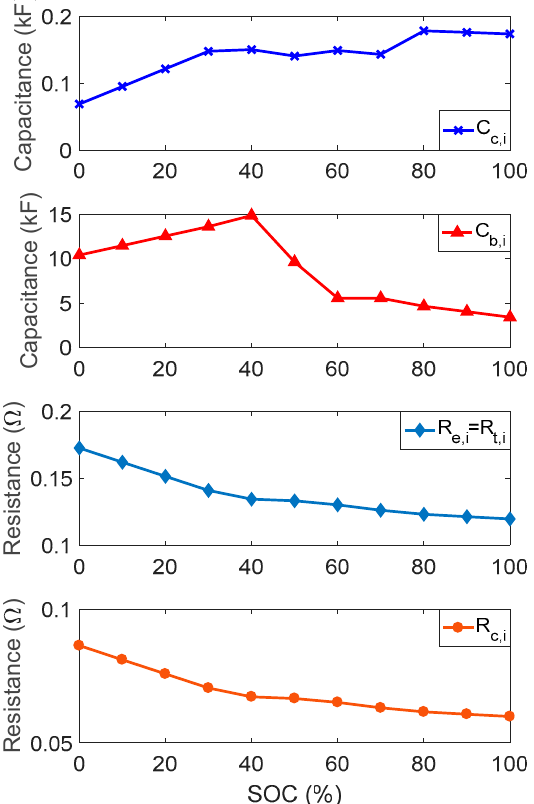
Figure 7. Parameters of a single battery cell for RC battery model.